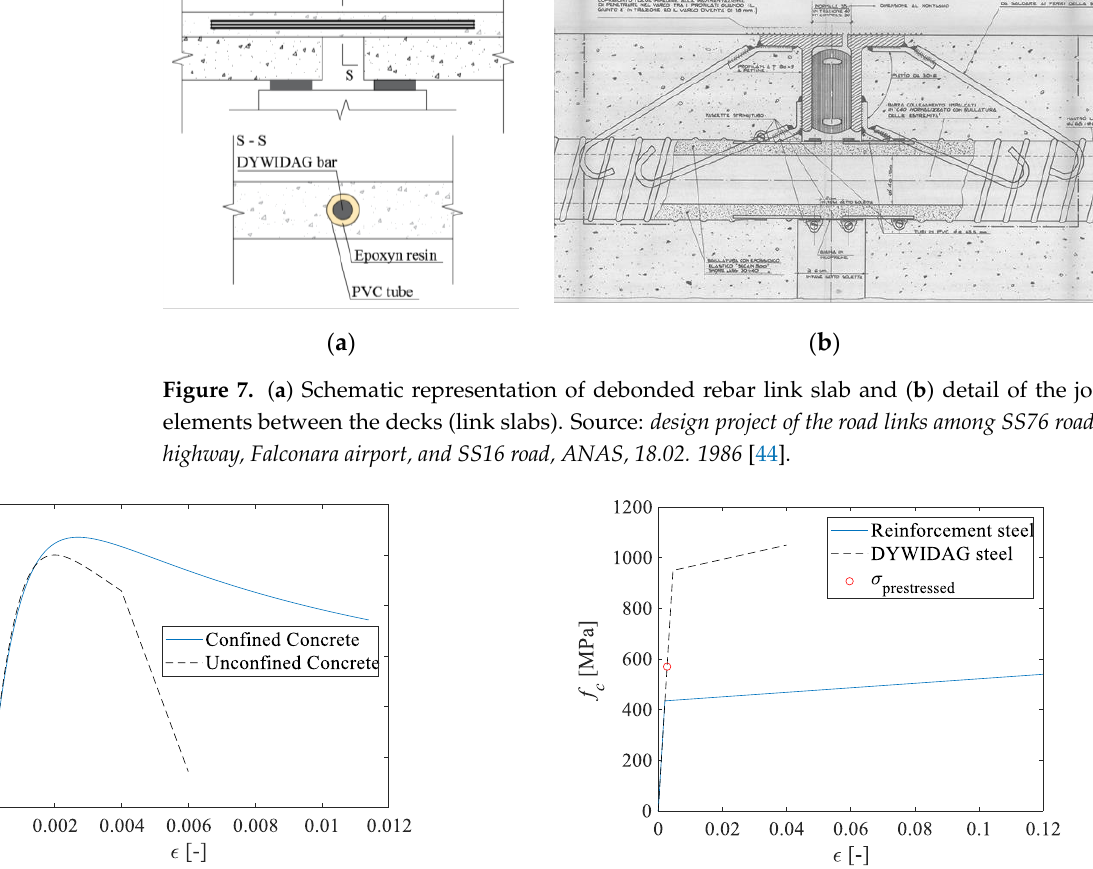
Figure 8. ( a ) Concrete constitutive laws; ( b ) Steel constitutive law.